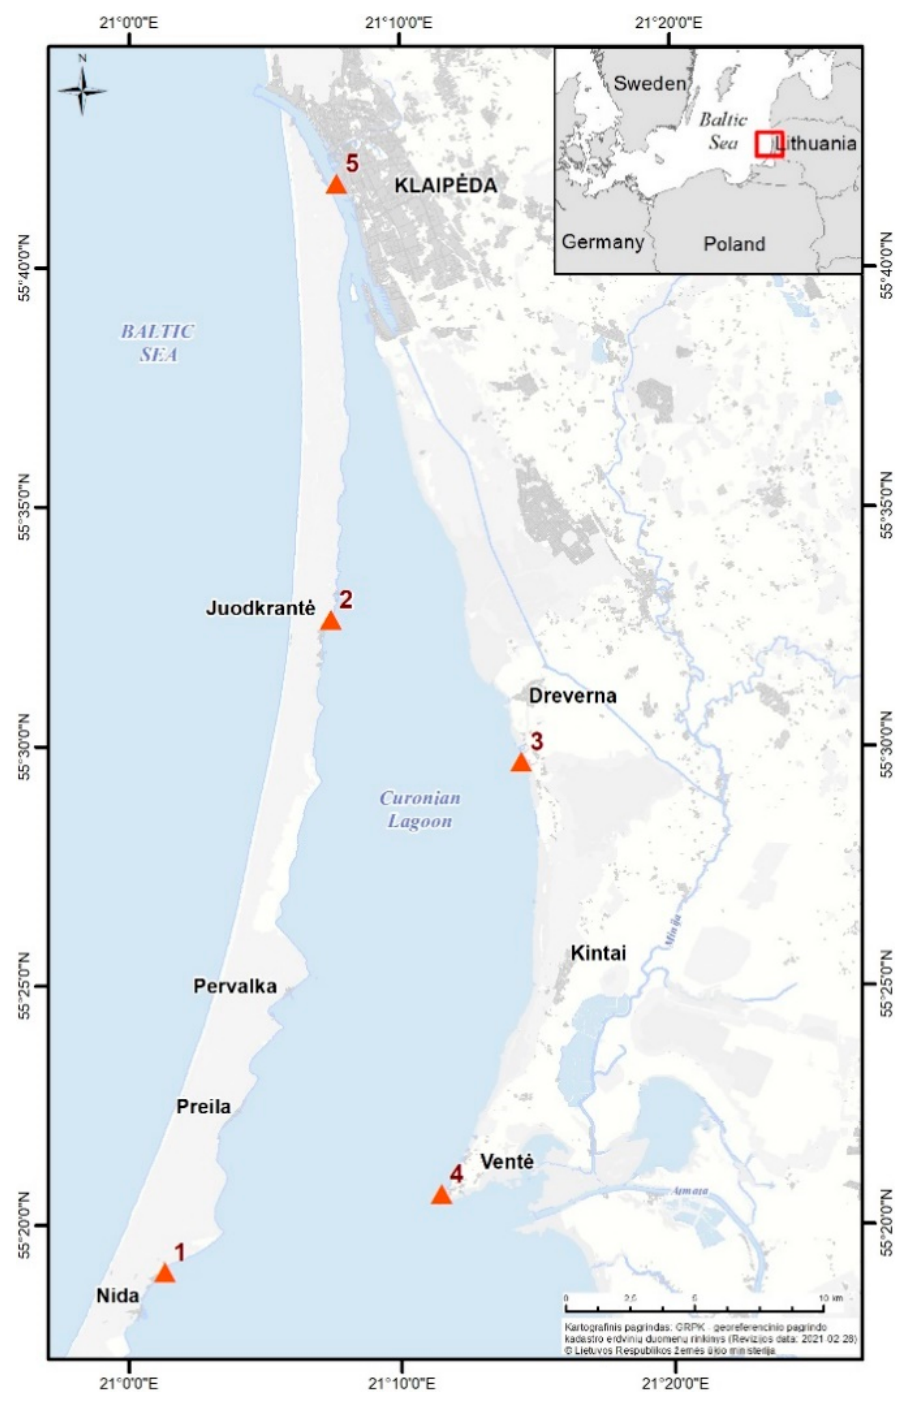
Figure 1. Study sites in the Curonian Lagoon. The numbers indicate the sampling stations: Station